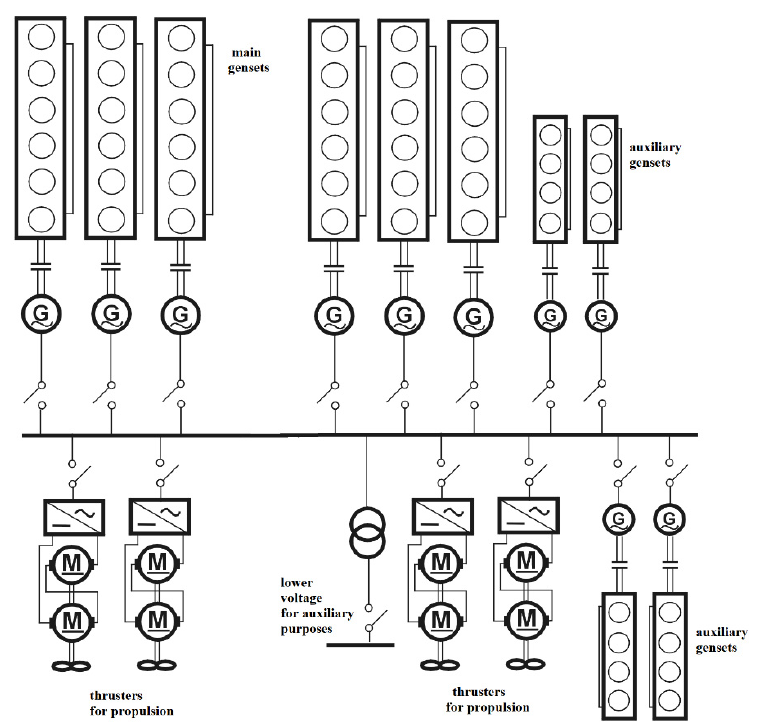
Figure 3. Diesel-electric system with 6 main and 4 auxiliary gensets (own drawing).